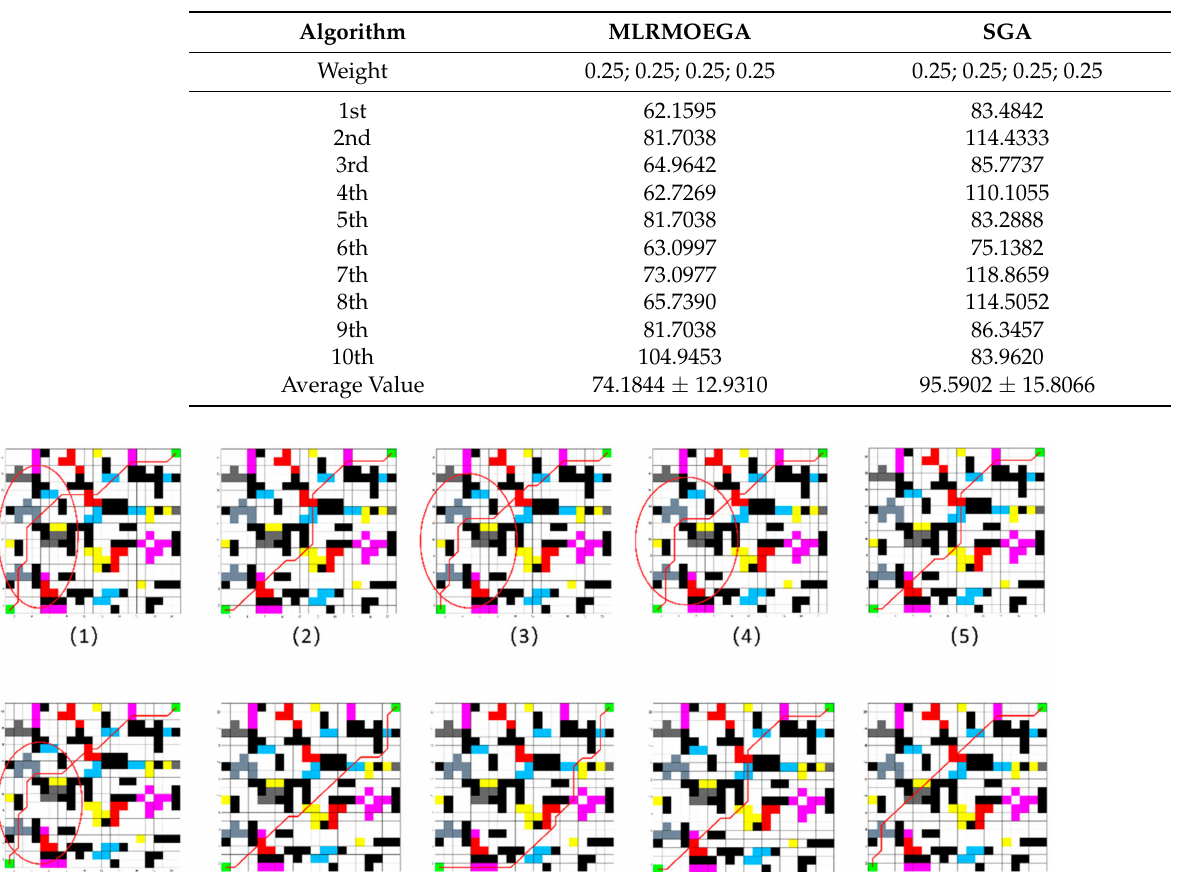
Table 7. The results of the test (20 × 20 grid map).